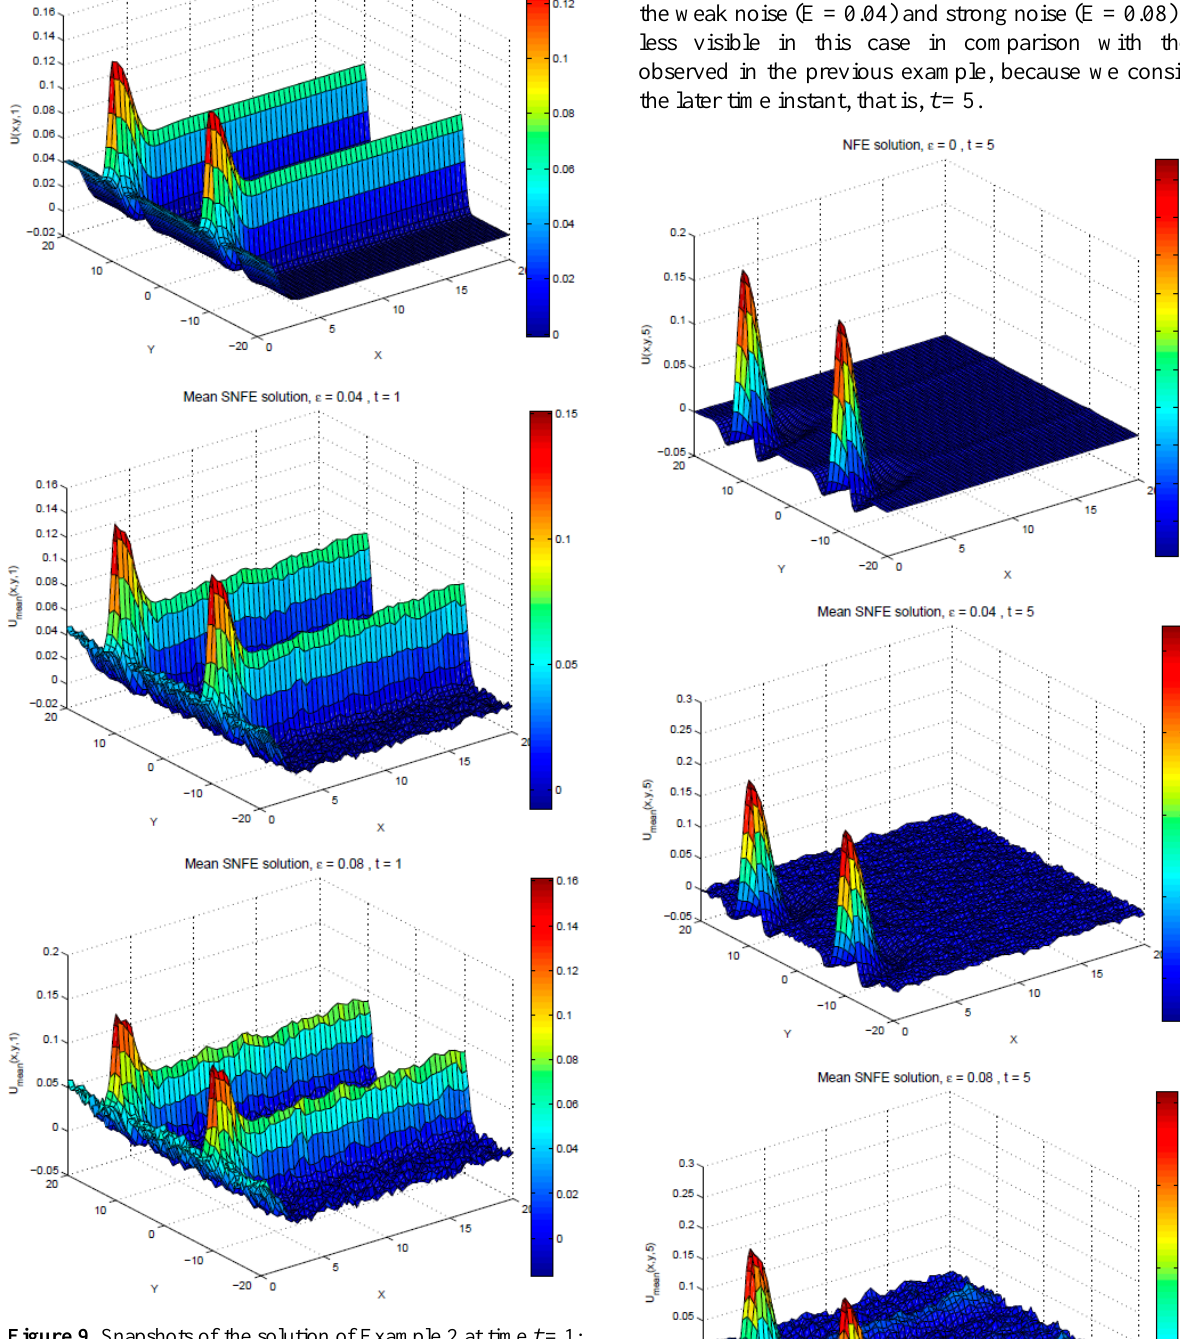
Figure 9. Snapshots of the solution of Example 2 at time t = 1: up- E = 0; down, left-hand side -E = 0.04; down, right-hand side - E = 0.08